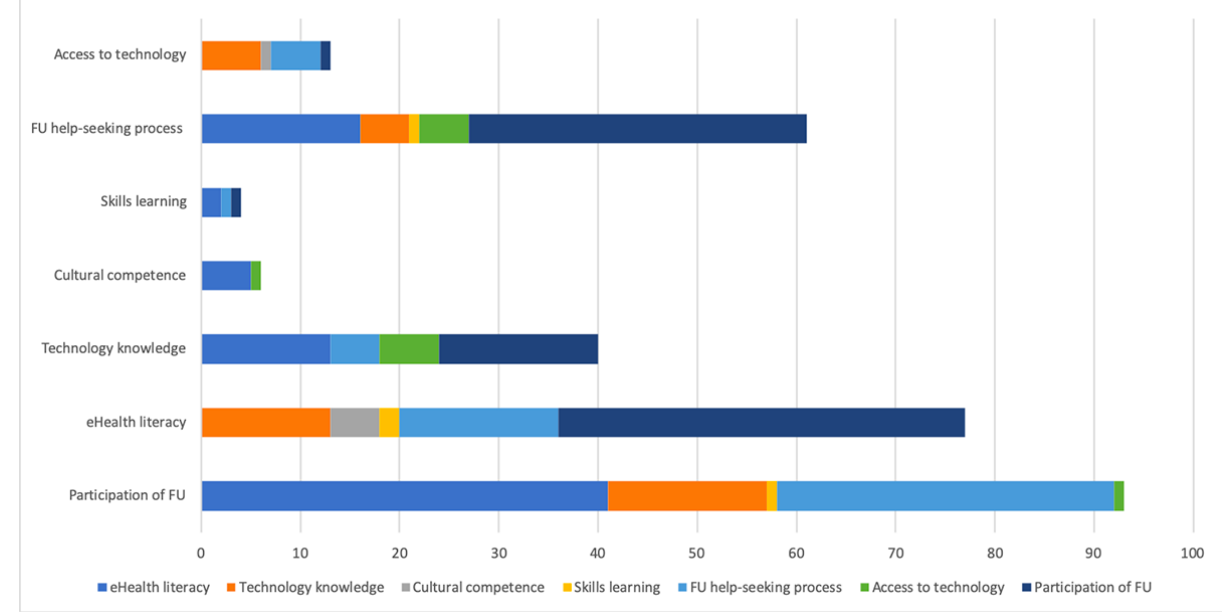
Figure 4. Co-occurence between codes. FU: Future